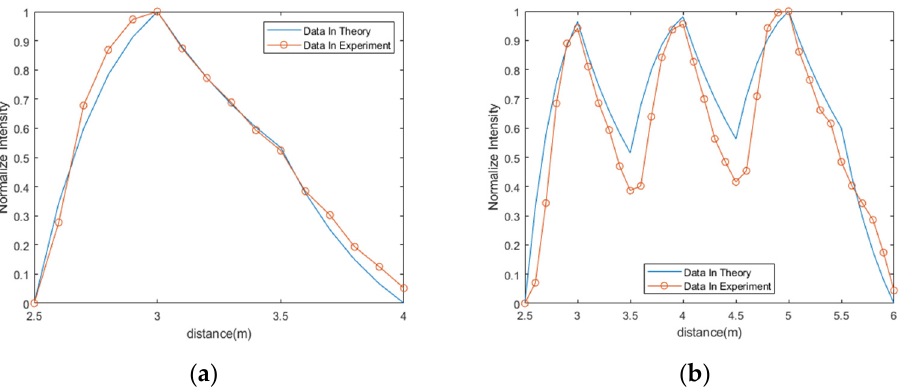
Figure 5. RIP data comparison between theory and experiment. ( a ) RIP of a single pulse; ( b ) RIP of MSI method.